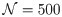
Cell colonies in a linear grid under complex illumination.Morphologies of several colonies under illumination from a single light source placed at the East. Each experiences a different intensity of incident light, depending on its location. The placement of the light source is such that the easternmost colony experiences the greatest incident light intensity. Thus, pphoto decreases linearly towards the West, as shown in the bottom bar. Each colony contains N=500 cells, and the model was simulated for 4 × 104 time steps.